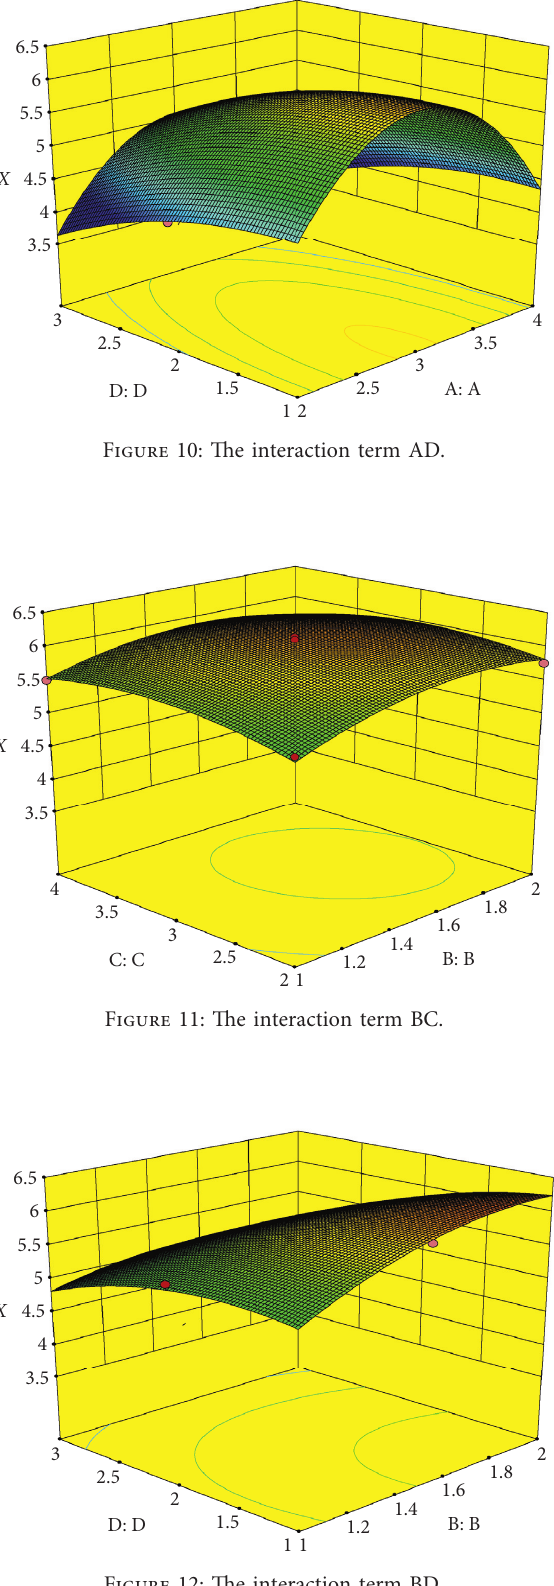
Figure 12: The interaction term